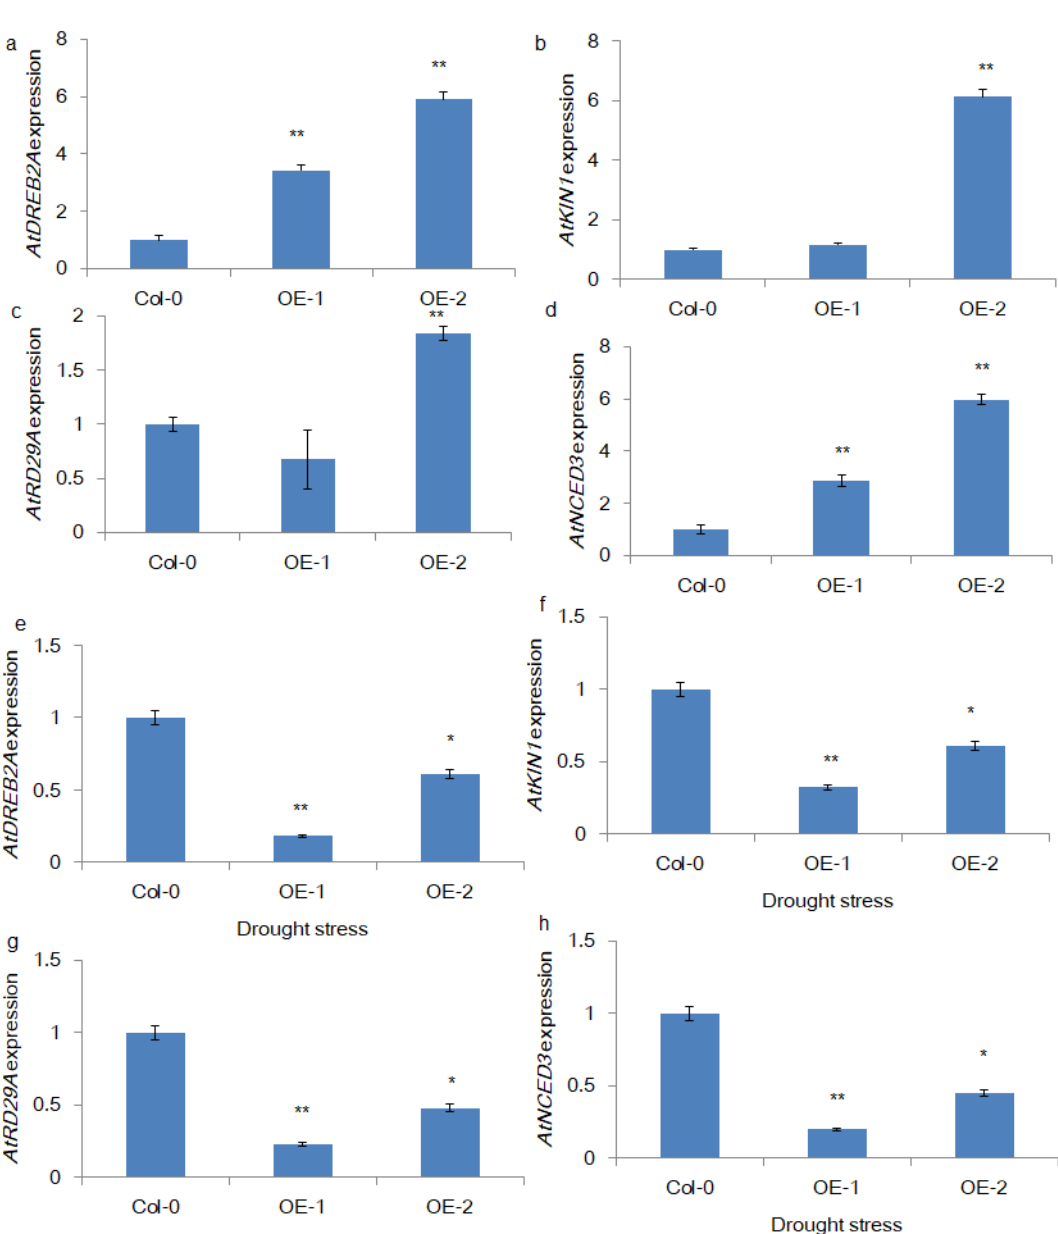
Figure 5. Expression patterns of stress response genes in transgenic Arabidopsis seedlings. The relative quantification of the expression of stress response genes in transgenic Arabidopsis seedlings under normal ( a – d ) and drought stress (11-d) conditions ( e – h ) was measured using qRT-PCR (**, * represents the statistical significance calculated from triplicate measurements).